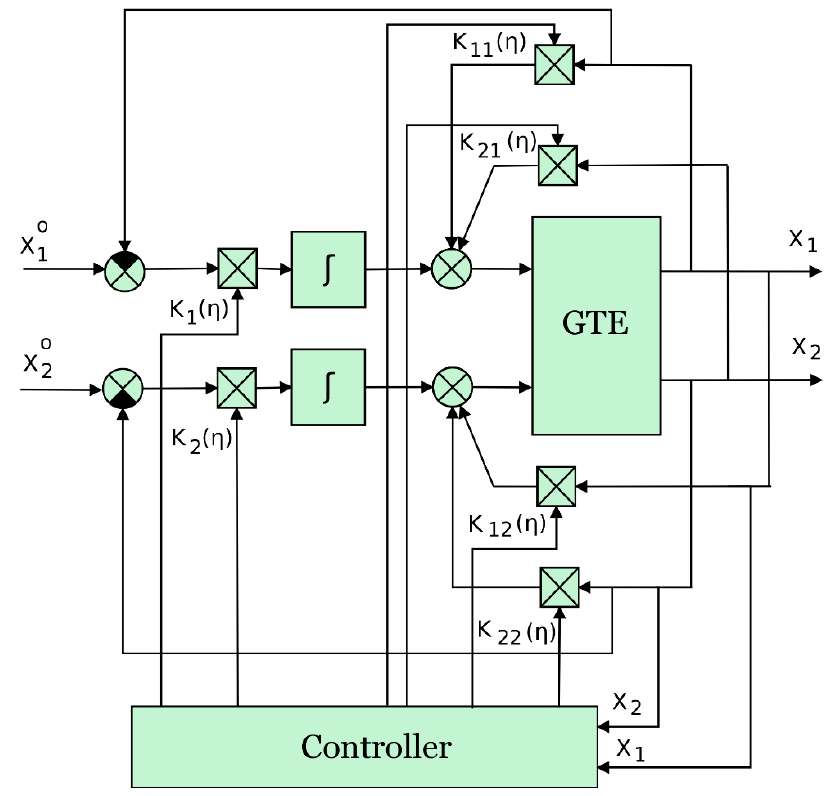
Figure 5. Nonlinear control system of the gas turbine engine (GTE).